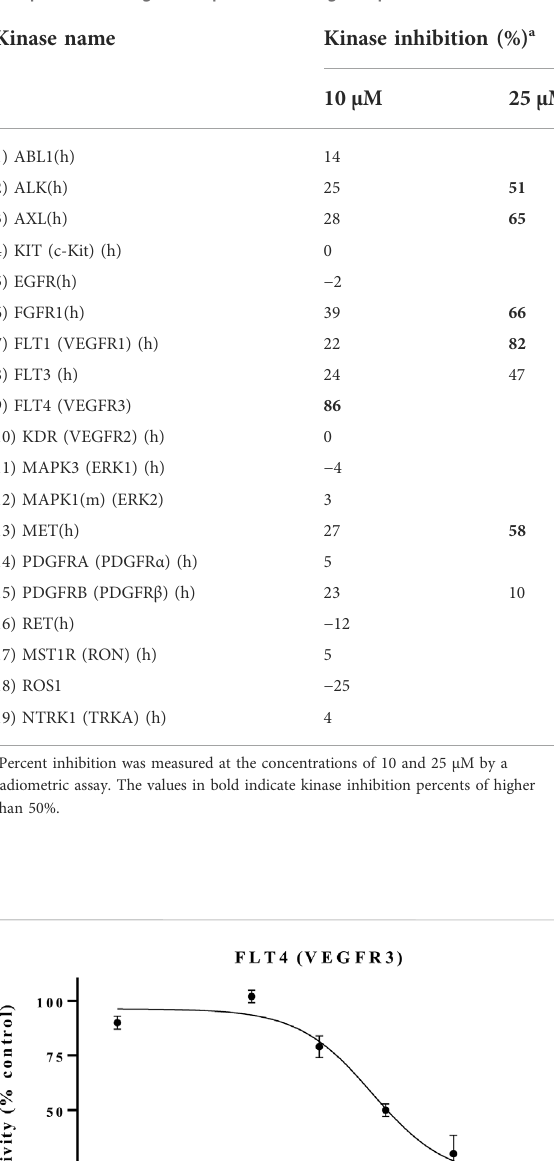
TABLE 4 Measurement of the inhibitory effects of synthetic compound CM9 against a panel of oncogenic protein kinases. Kinase name Kinase inhibition (%) a